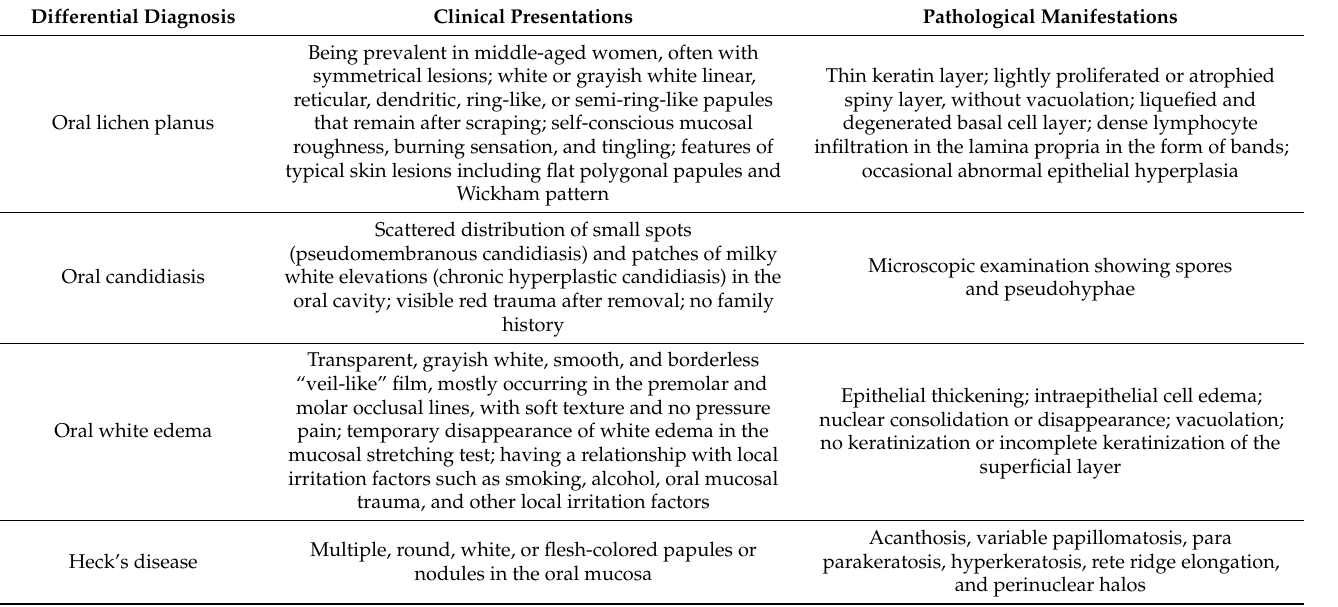
Table 2. Differential diagnosis between WSN and oral lichen planus, oral candidiasis, oral white edema, and Heck’s disease